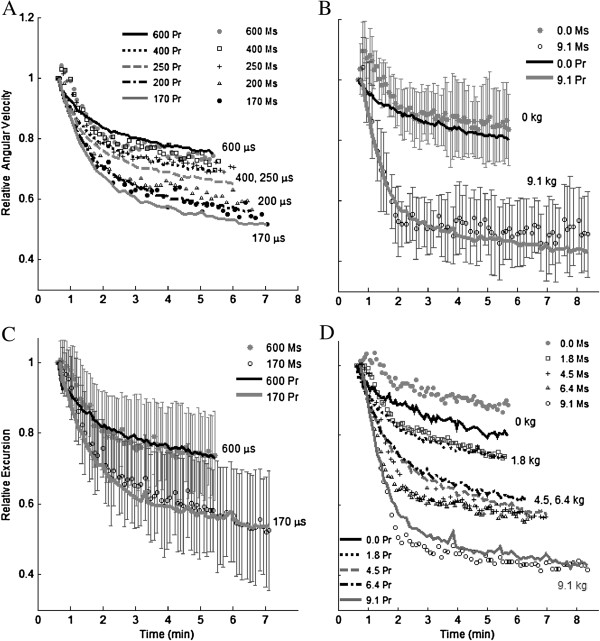
Measured (Ms) and predicted (Pr) pulse duration (A,C) and load (B,D) dependent reduction in relative angular velocity (A and B±SD) and excursion (C±SD and D) during fatiguing contractions. Angular excursion is defined as the difference between the initial and final knee angle of a leg extension. The 33CFT contractions shown are normalized to the first contraction. Measurements for (B) and (D) were collected in our previous study
[16]. Predictions are within one standard deviation of measurements, with the exception of the first 1.5 minutes of the 0 kg load. In (A) and (C) applied load is 4.54 kg and average train durations in (A), from shortest to longest pulse duration, are 0.64, 0.51, 0.36, 0.29, and 0.24 seconds. In (B) and (D) pulse duration is 600 μs and average train durations in (D), from highest load to lowest load, are: 0.89, 0.54, 0.51, 0.32, 0.19 seconds. Maintaining a constant excursion necessitated changing the train duration. Only 2 loads and pulse durations are shown in (B) and (C), respectively, so that the standard deviations could be shown.